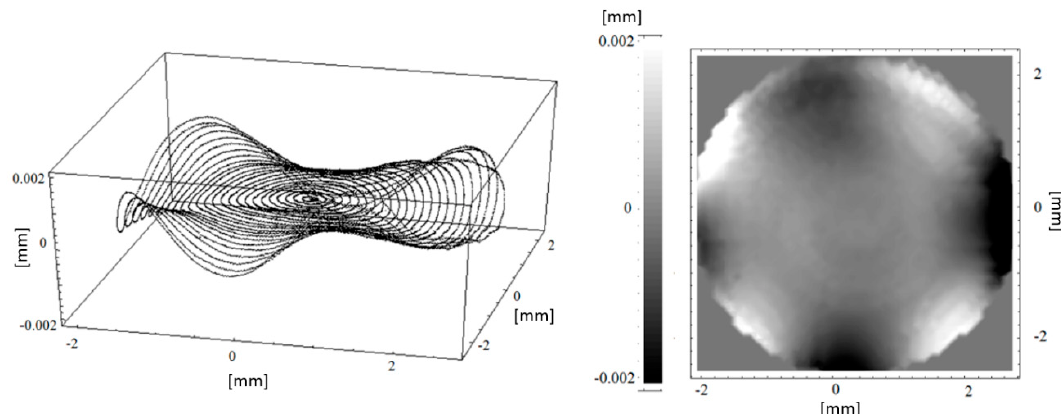
Figure 5. Surface residuals of the freeform optics manufactured using the µIM/comp-process (data set on a reduced 48 × 48 grid). Left : plotted on the concentric measuring path; right : Contour plot.